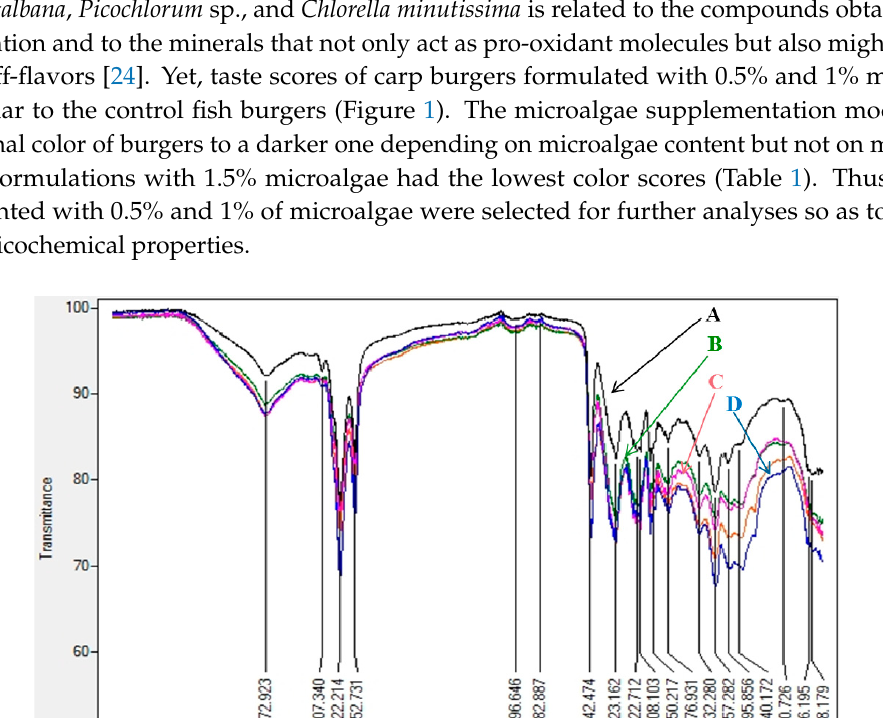
Table 2. Mean values for physicochemical characteristics of control and microalgae-fortified burgers at one week after production. Control Burger